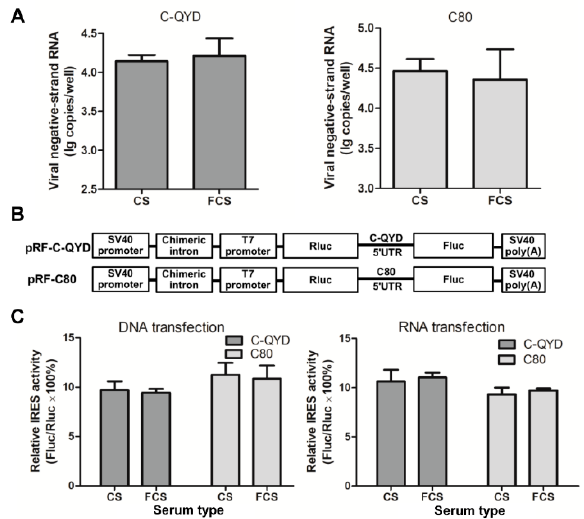
Figure 6. Analysis of e ff ect of FCS on gene expression in DHAV-1-infected DEF cells. ( A ) Determination of e ff ect of FCS on RNA replication. The negative strand replicative–intermediate of DHAV-1 was quantified at 6 hpi. ( B ) Schematic diagram of bicistronic reporter plasmids. ( C ) Analysis of e ff ect of FCS on DHAV-1 IRES-mediated translation. Left panel, DEF cells were transfected with the bicistronic DNA plasmids. The activity of Fluc and Rluc was measured at 24 h after transfection. Right panel, DEF cells were transfected with in vitro transcribed RNA. The activity of Fluc and Rluc was measured at 17 h after transfection. Error bars represent the SD ( n =